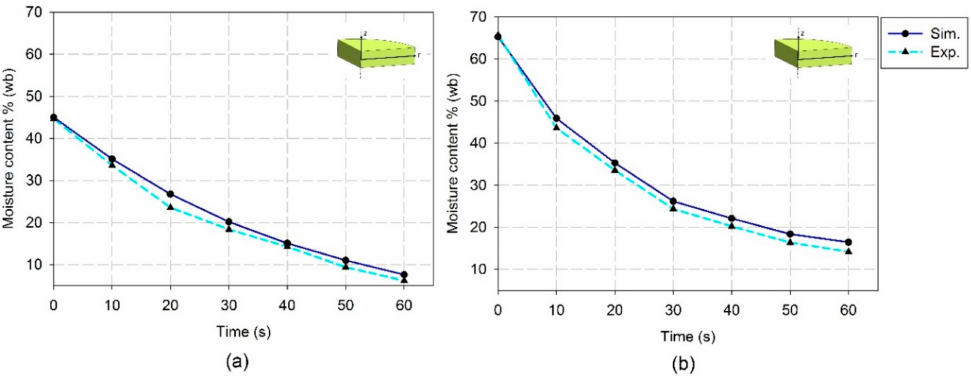
Figure 7. Comparison between predicted and experimental values of average moisture content of the sample during dehydration; ( a ) unripe bananas; ( b ) ripe bananas.